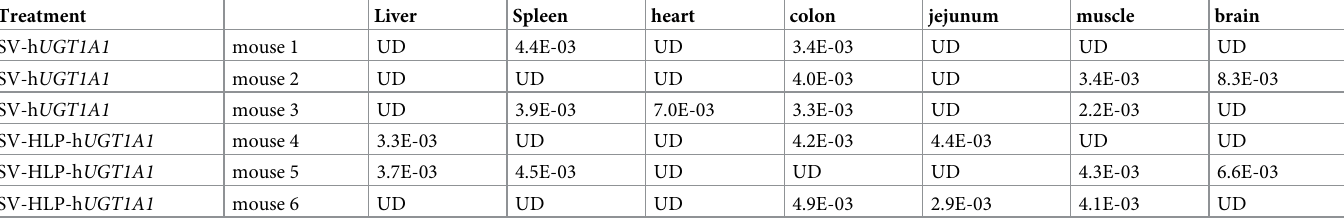
Table 1. Bio-distribution of rSV vector genomes.